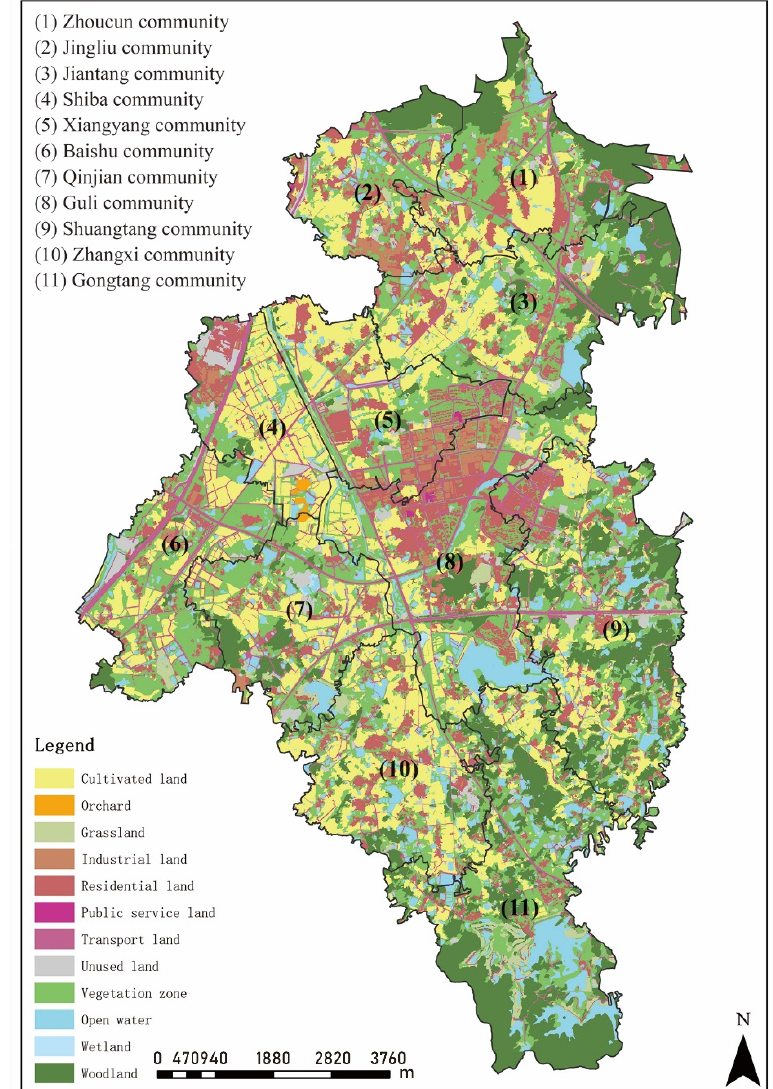
Figure 2. Land-use classification of Guli Street in Nanjing city.